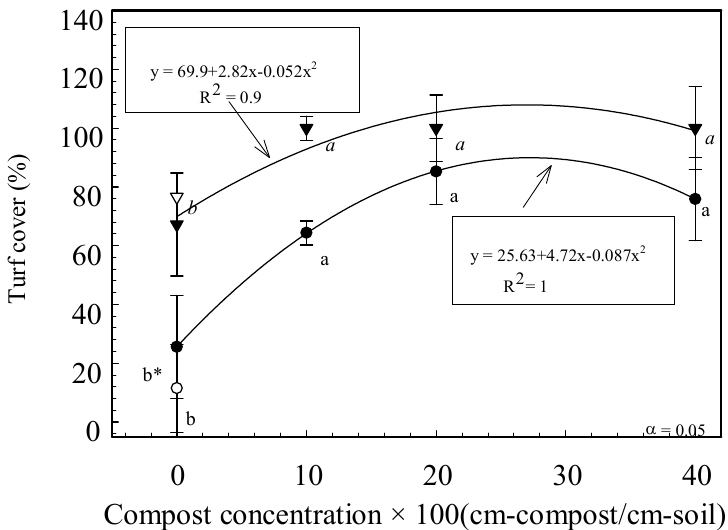
Figure 2. Effect of incorporating composted poultry litter into top 12.7 cm of subsoil on seeded Kentucky bluegrass cover for ● April-seeded, compost; ○ April-fertilizer; ▼ Sept.-sodded, compost; and Sept.-fertilizer; * Means with same letters are statistically insignificant based on Fisher’s Protected LSD test ( P ≤ 0.05) (italicized statistics correspond to sodded treatments).